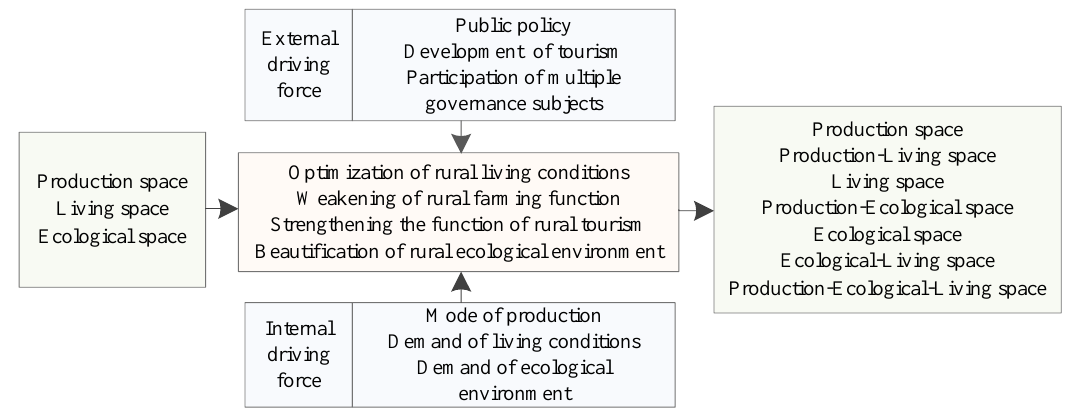
Figure 5. Driving mechanism of space reconstruction of rural tourism areas.